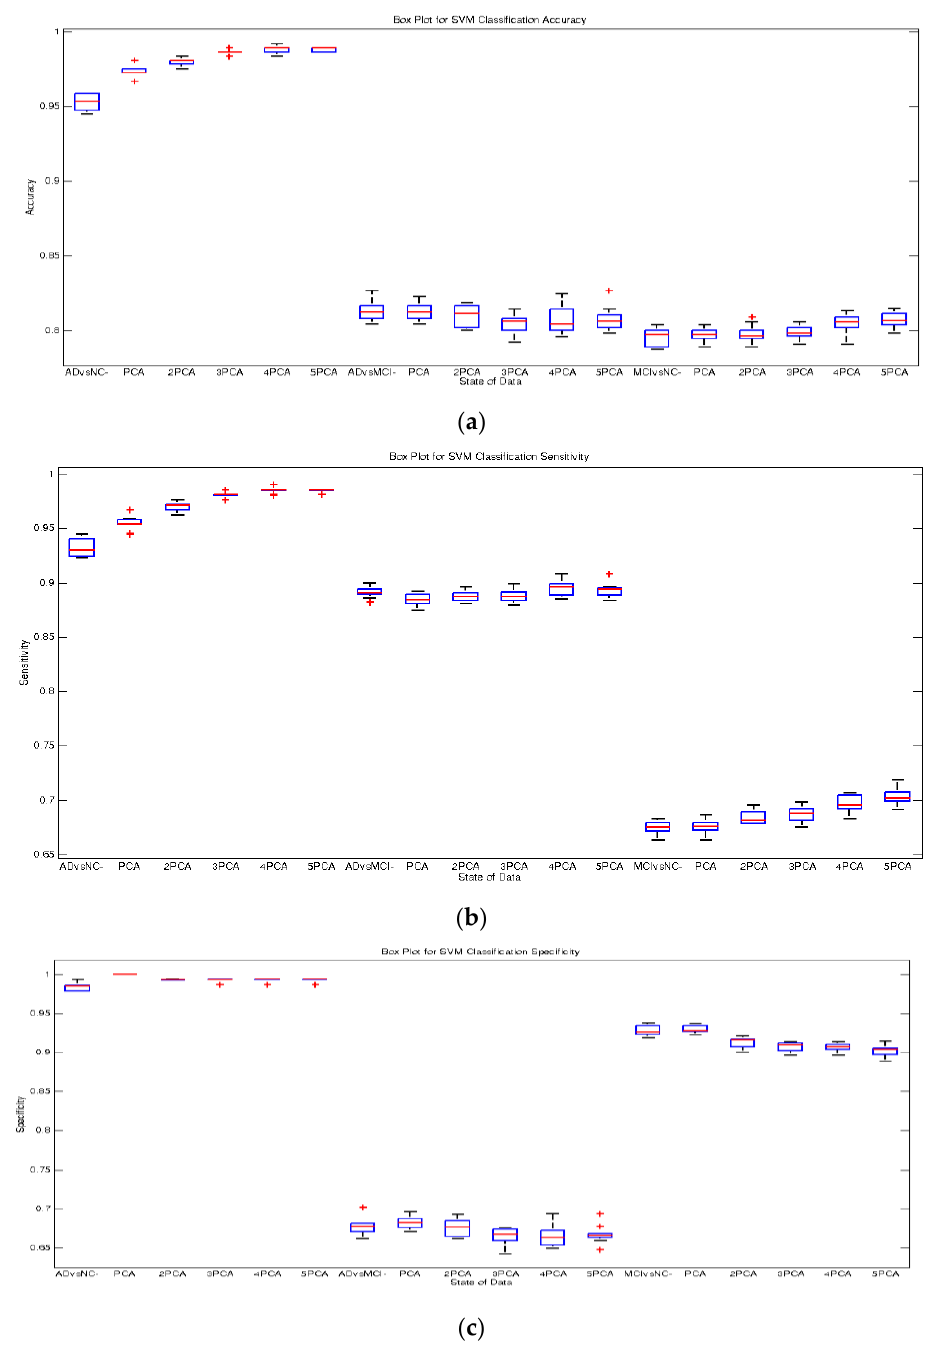
Figure 5. Boxplots for the recognition of AD, MCI, and NC subjects: ( a ) accuracy, ( b ) sensitivity, and ( c ) specificity of all features and 25 PCA elements for 1 – 9× repeated feature reduction.